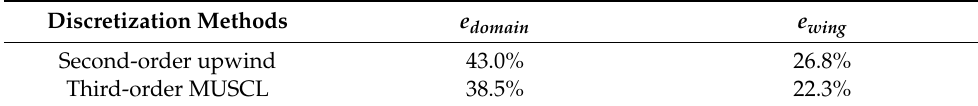
Table 7. Power imbalance error for the discretization methods.